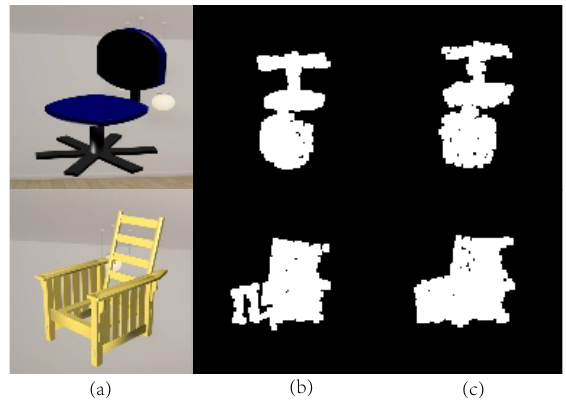
Figure 8. Two samples of projection from the same viewpoint. ( a ) Rendered input images. ( b ) Projection of the ground truth. ( c ) Projection of the generated